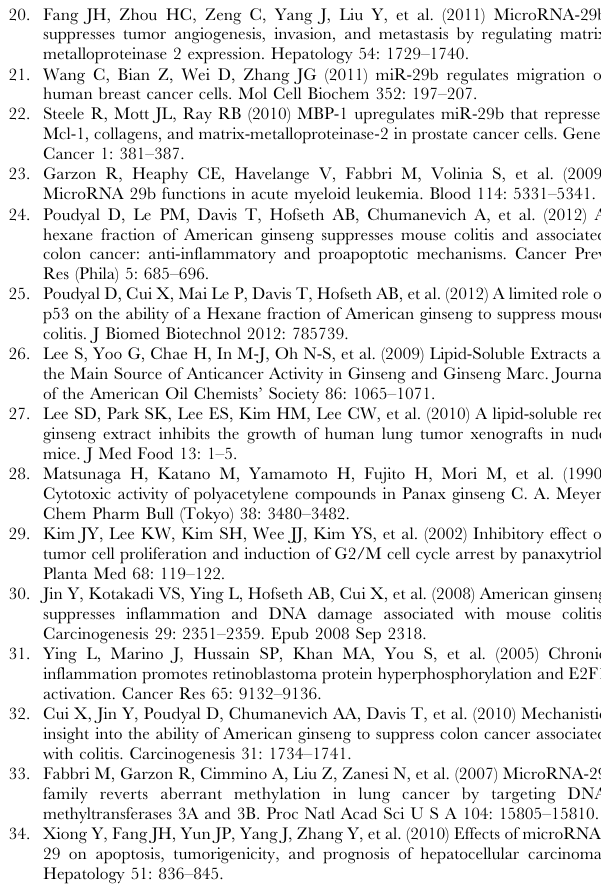
Figure S2 MMP-2 is the key factor in the migration of HCT-116 cells. Collagen type-I (15 m g/mL) coated transwell chamber were applied with 5 6 10 4 HCT116 cells or MMP-2 k/d HCT116 cells for 12 h. The lower chamber contains SFM or